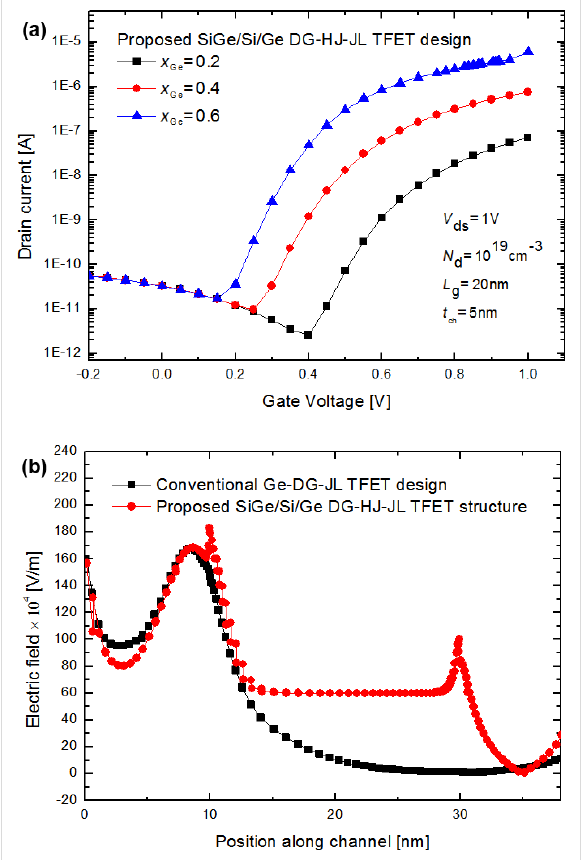
Figure 3: (a) Transfer characteristics of the proposed Si 1 − x Ge x /Si/Ge DG-HJ-JL TFET as a function of the Ge concentration with N d = 1·10 19 cm − 3 , V ds = 1 V, t ox = 2 nm, L g = 20 nm and t ch = 5 nm. (b) Distribution of the electric field along the channel of the proposed Si 1 − x Ge x /Si/Ge DG-HJ-JL TFET structure and the conventional Ge-DG-JL TFET design with N d = 1·10 19 cm − 3 , t ch = 5 nm, t ox = 2 nm, L g = 20 nm and L s = 10